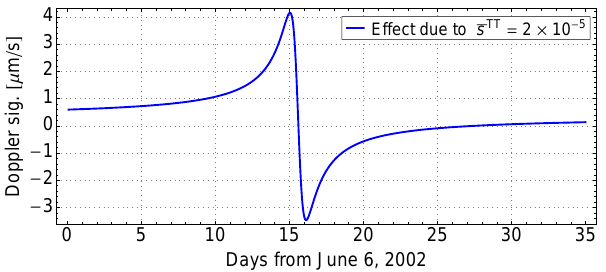
Figure 2. Doppler signature produced by ¯ s TT = 2 × 10 − 5 on the 2-way Doppler link Earth-Cassini-Earth during the 2002 Solar